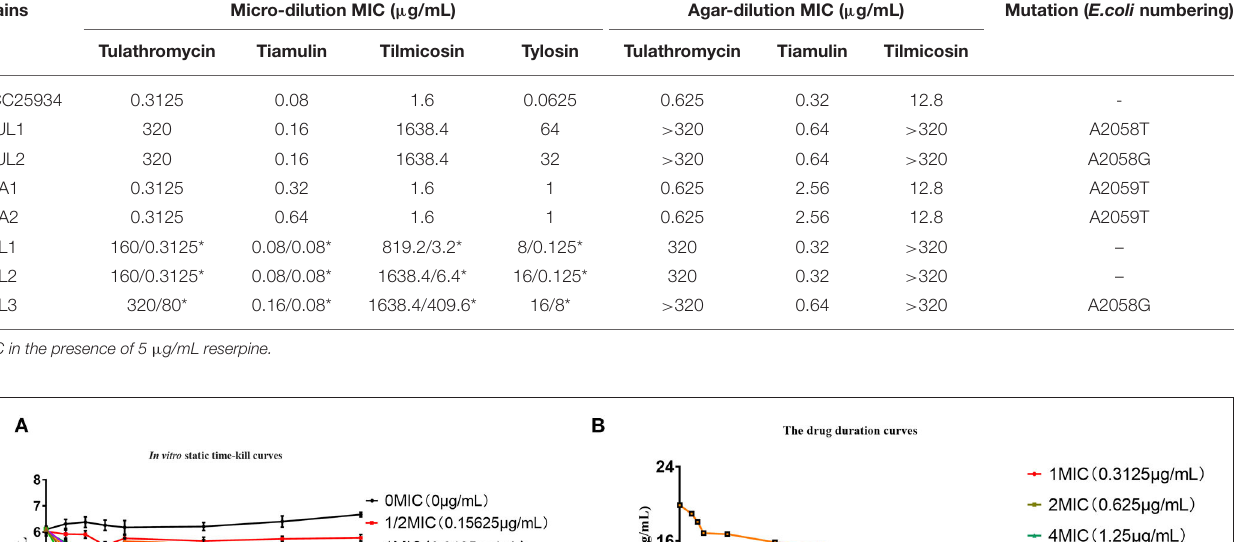
TABLE 1 | MIC and MPC of four antibiotics against M. hyopneumoniae and mutants. Strains Micro-dilution MIC ( µ g/mL) Agar-dilution MIC ( µ g/mL) Mutation ( E.coli numbering) Tulathromycin Tiamulin Tilmicosin Tylosin Tulathromycin Tiamulin Tilmicosin